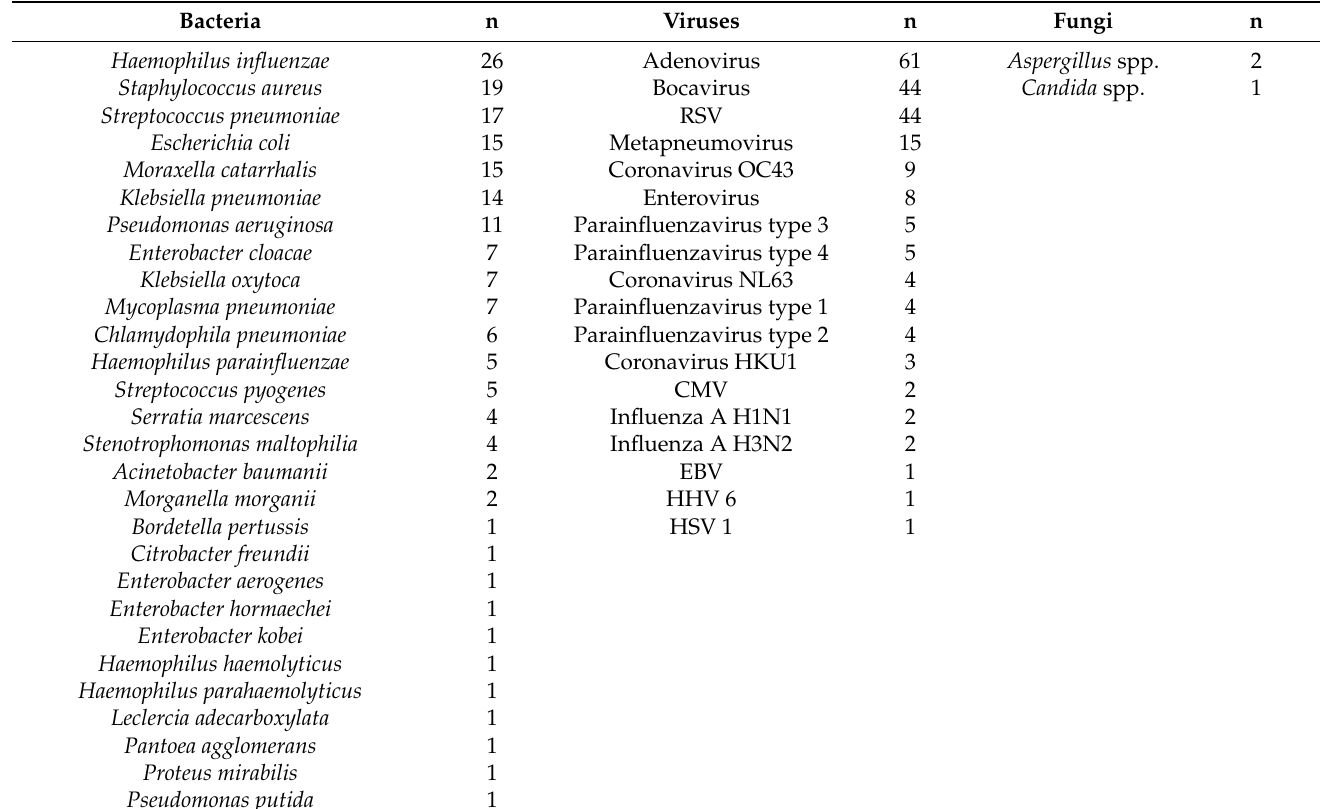
Table 3. Distribution of co-infecting